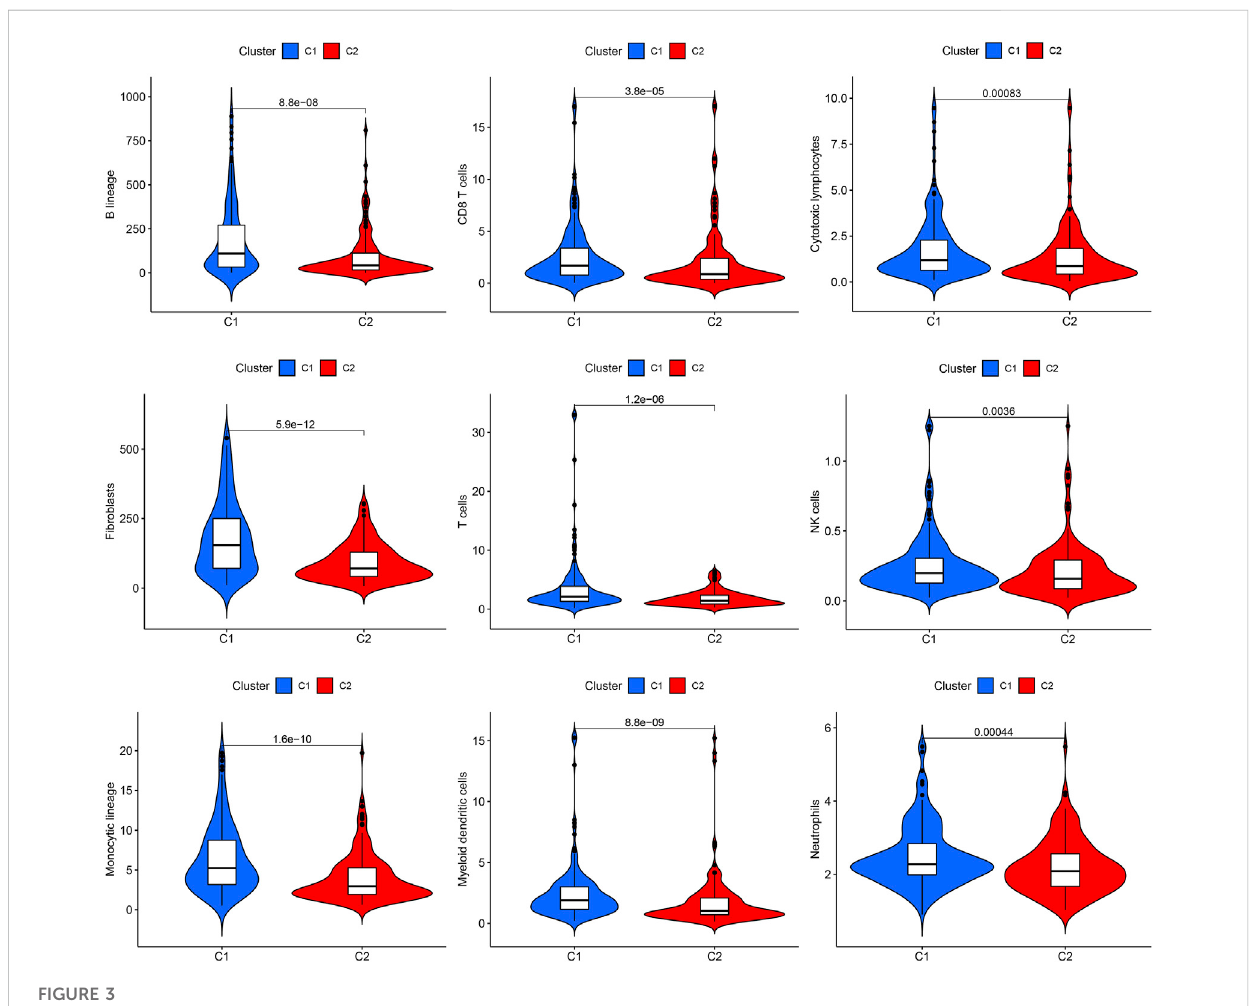
FIGURE 3 Immune cell in fi ltrations of cluster 1 and